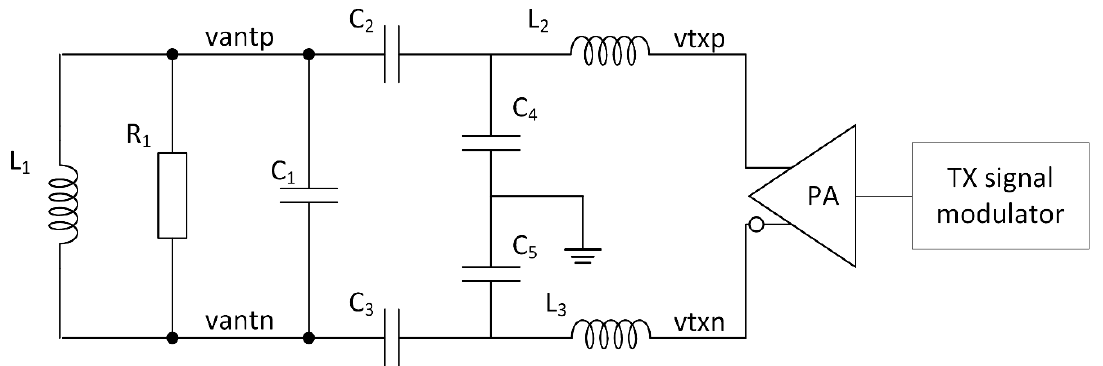
Figure 6. Tag antenna model, where L1, R1, C1, C2 and C3 form a resonant LC tank and L2, L3, C2 and C4 form a low-pass EMC filter. TX signal modulator and the power amplifier (PA) are driving the antenna. Table 1. Elements values used in models of the reader and the tag.